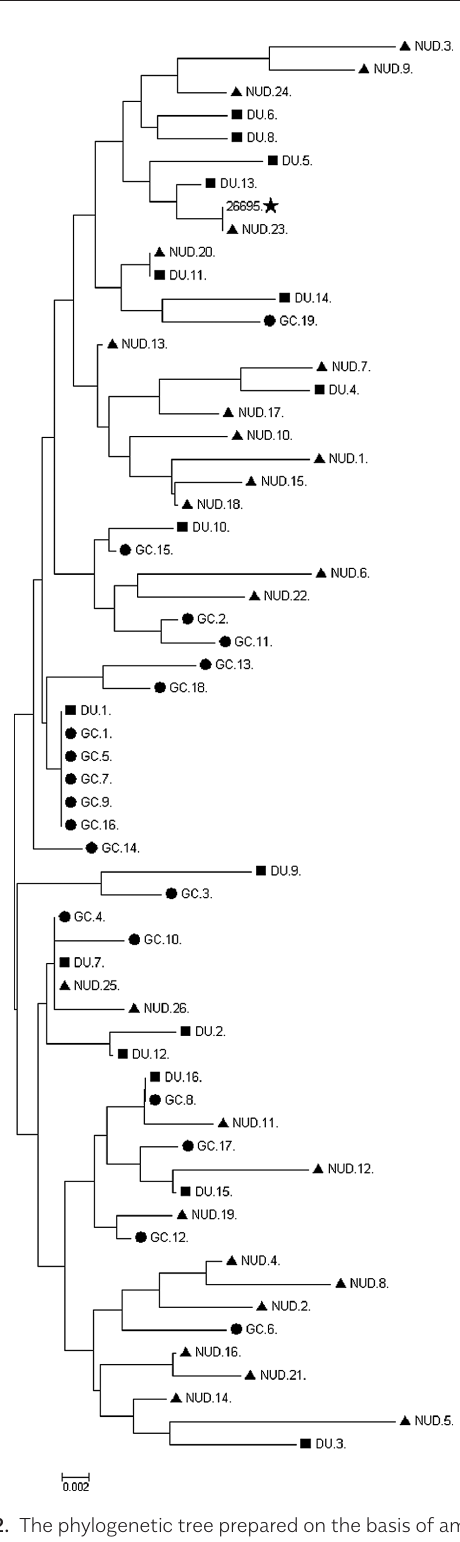
Figure 2. The phylogenetic tree prepared on the basis of amino acid polymorphisms detected in the study and control